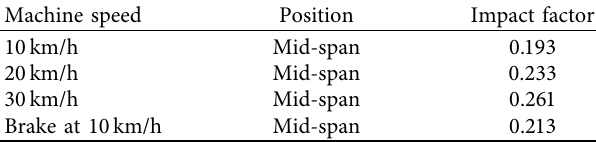
Table 4: Impact factor at different speeds at middle span.